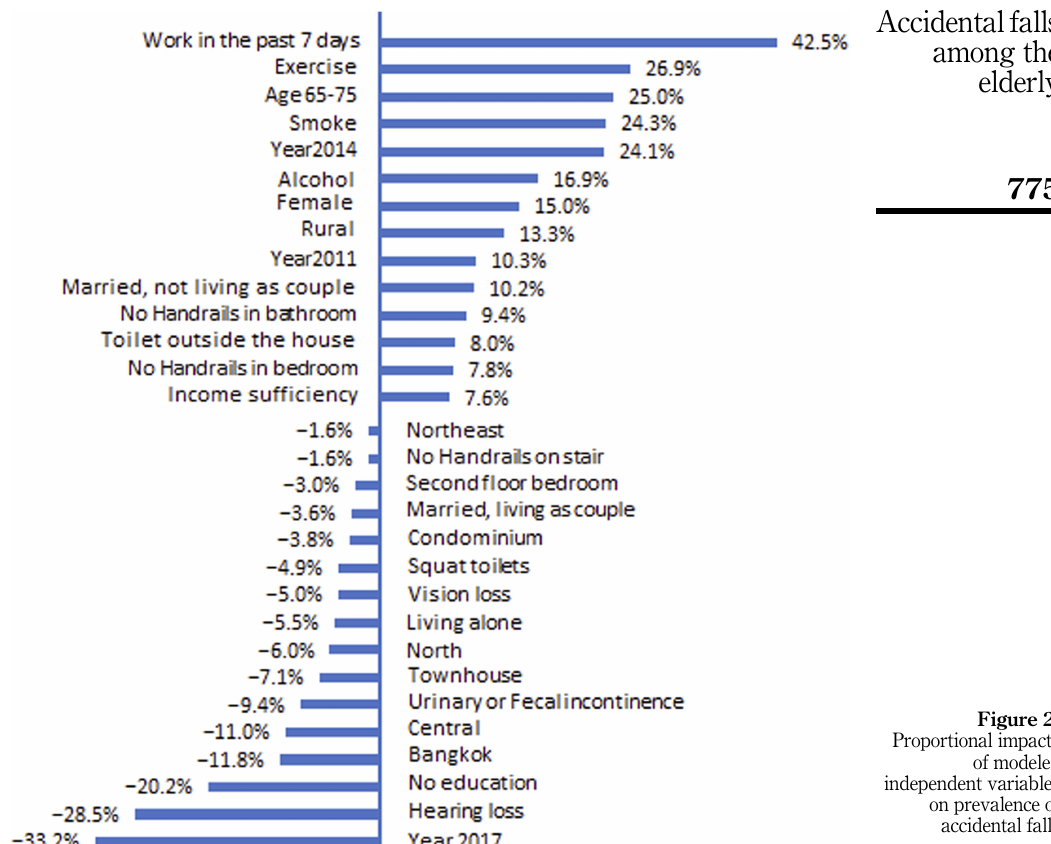
Figure 2. Proportional impacts of modeled independent variables on prevalence of accidental